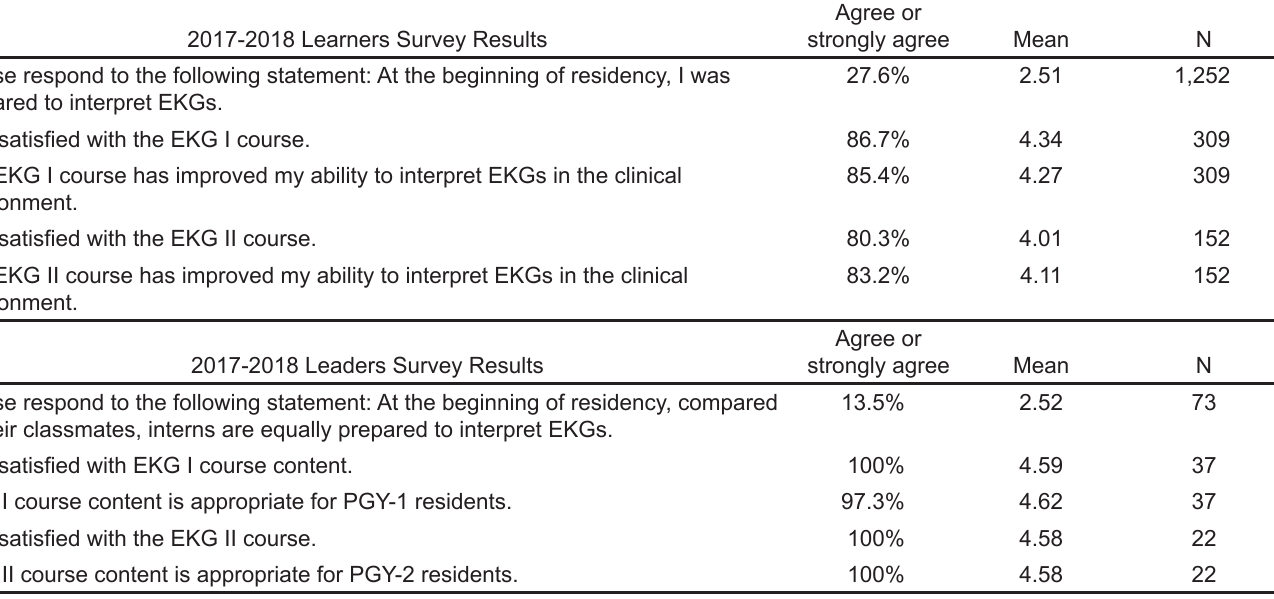
Table 2. 2017-2018 Foundations EKG Learner and Leader Survey